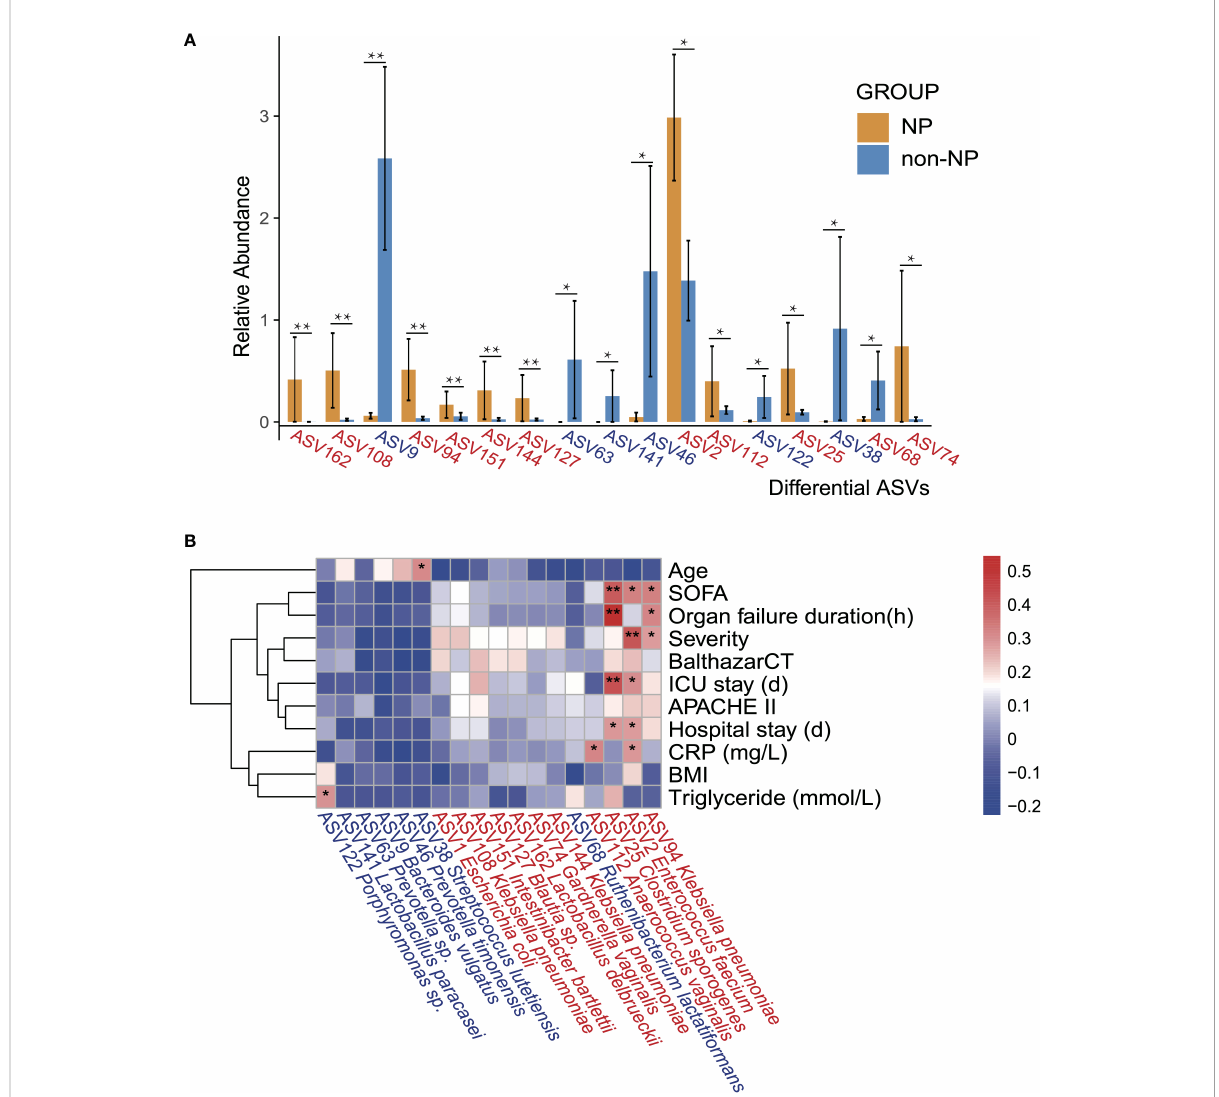
FIGURE 4 Differential ASVs between NP and non-NP groups and the correlation with clinical indicators. (A) Bar plot showing the relative abundance of differential ASVs between the NP and the non-NP groups. Values represent mean ± SEM, SEM-standard error of mean. * p < 0.05, ** p < 0.01, edgeR test. (B) Spearman correlations between differential ASVs and clinical outcomes as well as indicators of disease severity. ASV, amplicon sequence variants; SOFA: the Sequential Organ Failure Assessment score; Severity: MAP-mild acute pancreatitis, MSAP-moderately severe acute pancreatitis and SAP-severe acute pancreatitis; BalthazarCT: Balthazar score within the CT severity index for grading of acute pancreatitis; APACHE II: the Acute Physiology and Chronic Health Evaluation II score; CRP: C-reactive protein; BMI: body mass index; Positive (red) or negative (blue) correlation are shown by two-color heatmap, with asterisks denoting statistical signi fi cance (* p < 0.05, ** p < 0.01). ASVs enriched in the NP group were highlighted in red, and ASVs enriched in the non-NP group were in